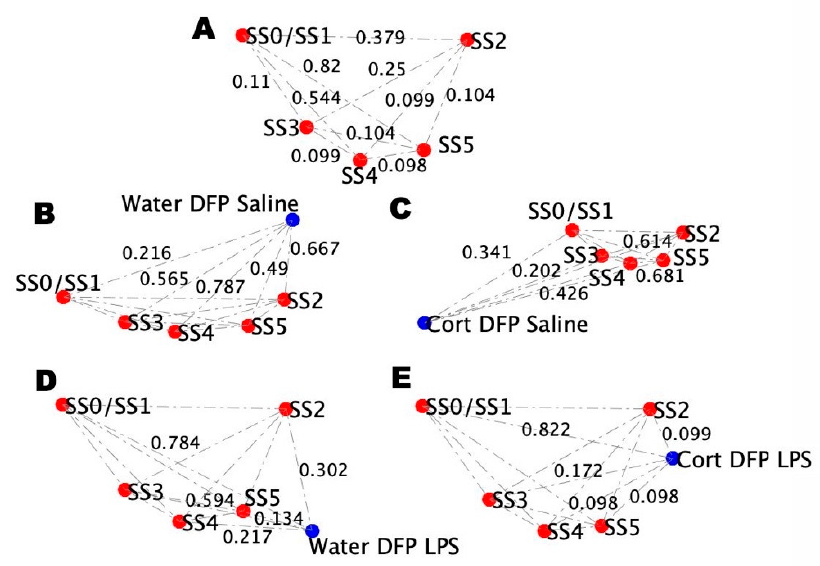
Figure 8. Comparison of the mouse model conditions brain and blood profile topologies. ( A ) Topol- ogy of the distance between the simulated stable states using Brown’s method based on data from mice receiving a course of pure drinking water, an initial saline injection, and a follow-up injection of saline. ( B ) Topology of the distance between the simulated stable states from mice receiving a course of pure drinking water, an injection of DFP, and a follow-up injection of saline. ( C ) Topology of the distance between the simulated stable states from mice receiving a course of drinking water with CORT, an injection of DFP, and a follow-up injection of saline. ( D ) Topology of the distance between the simulated stable states of mice receiving a course of pure drinking water, an injection of DFP, and a follow-up injection of LPS. ( E ) Topology of the distance between the simulated stable states of mice receiving a course of drinking water with CORT, an injection of DFP, and a follow-up injection of LPS.